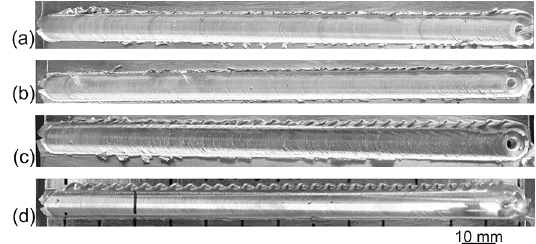
Figure 4. Top surface appearance of the welds: a) G1, b) G2, c) G3 and d) G4.